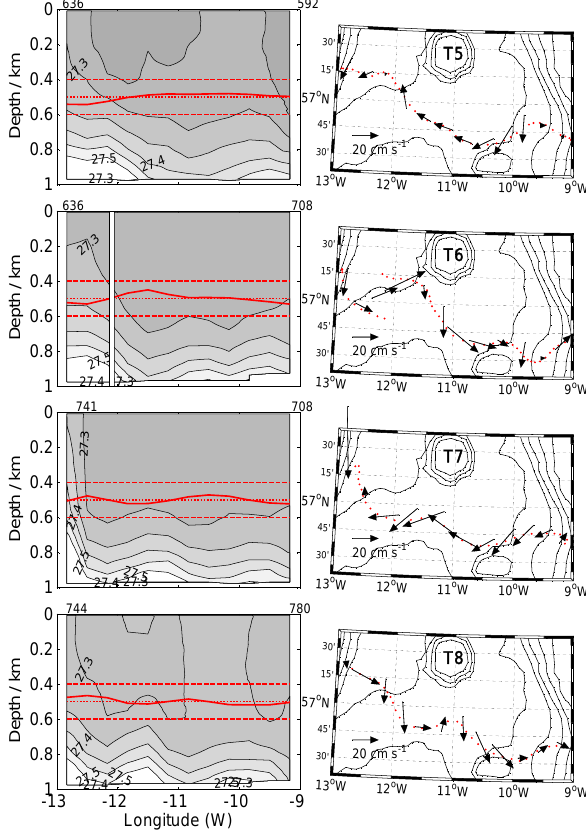
Figure 6a. Summary of observations from each of transits 1 to 4. LH column: density anomaly sections (kgm − 3 ) to 1000m along the dotted track shown in the accompanying map. Also, the SLA (plain red line) is plotted as cm about 500m (dotted red line), with the dashed red lines showing heights of ± 10cm. RH column: glider drift velocity vectors. All dive data (dotted red line) were averaged into 20 (cid:48) bins before plotting. The labels “T1”–“T4” over the ADS in the RH column identify transits 1 to 4; see also Table 1.